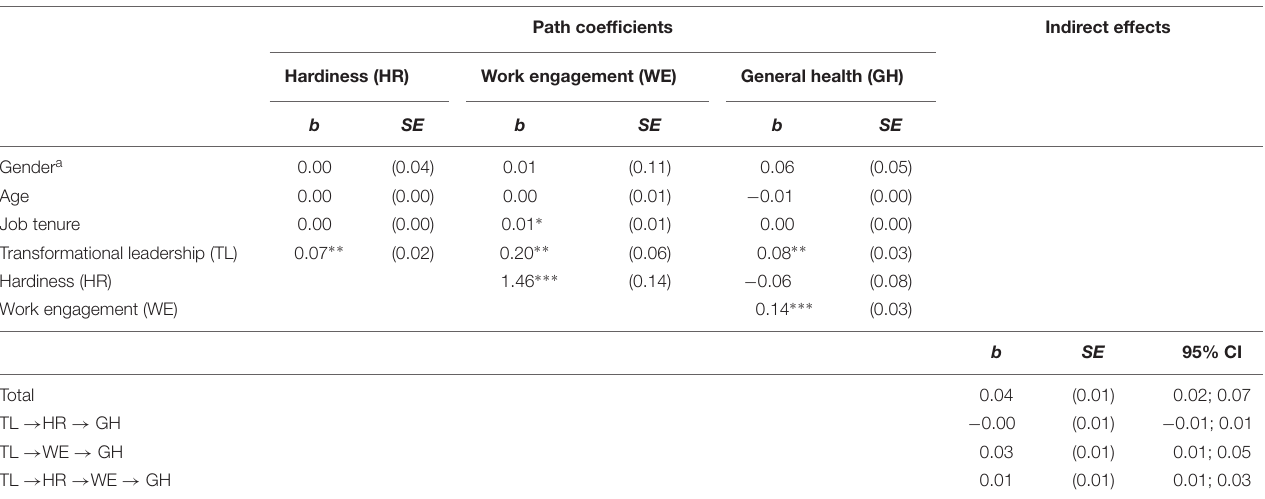
TABLE 2 | Path coefficients and indirect effects for mediation